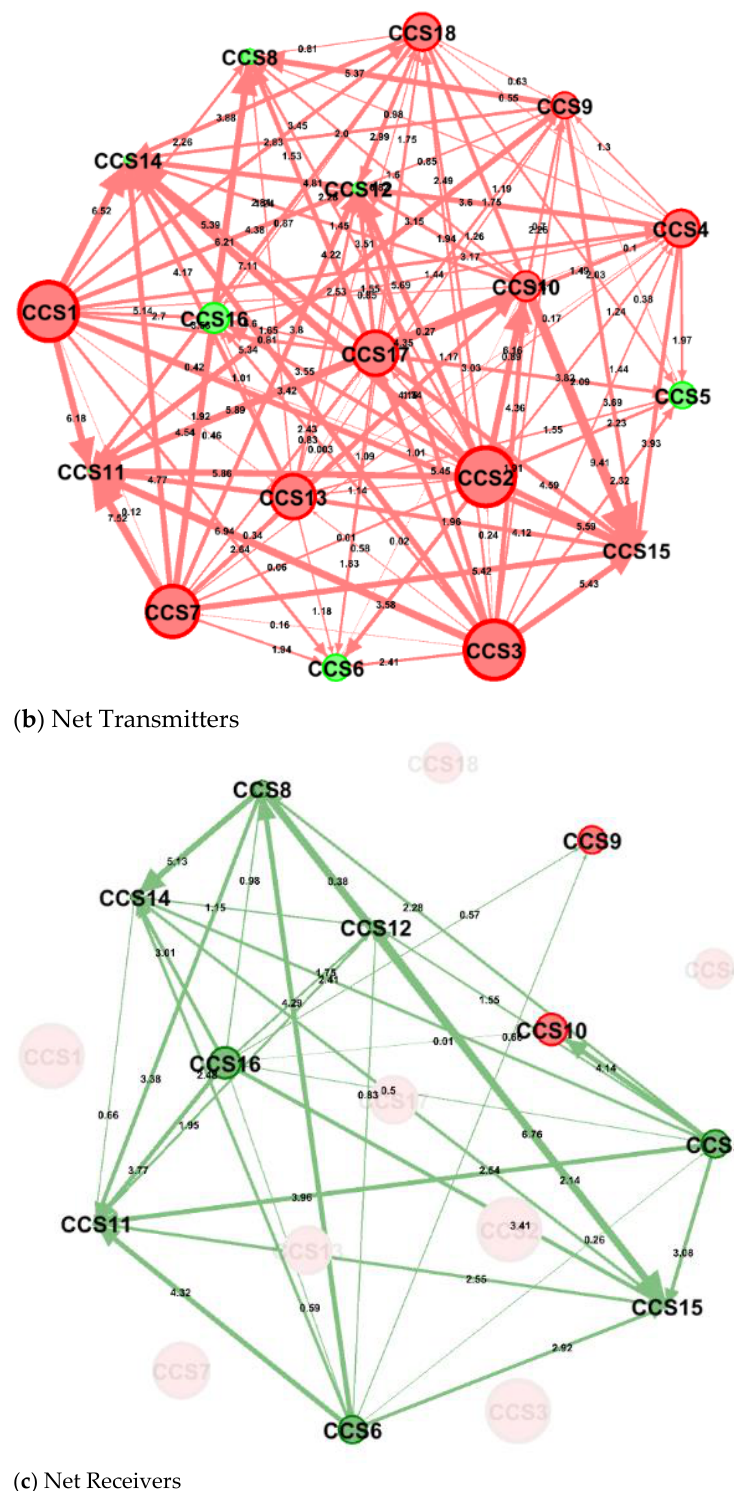
Figure 1. Static connectedness network structure of net-pairwise directional connectedness indices ( NPDCI ). ( a ) Complete Network: total connectedness index ( TCI ) is 87.20%. The size of nodes indicates the overall magnitude of transmission/reception of spillover for each clinical classification system (CCS) code. Red (green) color for a node denotes a specific CCS i ( i = 1, 2,…, 18) that is a net transmitter (receiver). The thickness of arrows reflects the strength of the spillover between a pair of CCS codes. Thicker arrows indicate stronger spillovers between two CCS codes. ( b ) Net Transmitters: Ten of these eighteen clinical diagnosis-related groups of diseases (these being infectious and parasitic diseases (CCS1), neoplasms (CCS2), endocrine, nutritional, and metabolic diseases